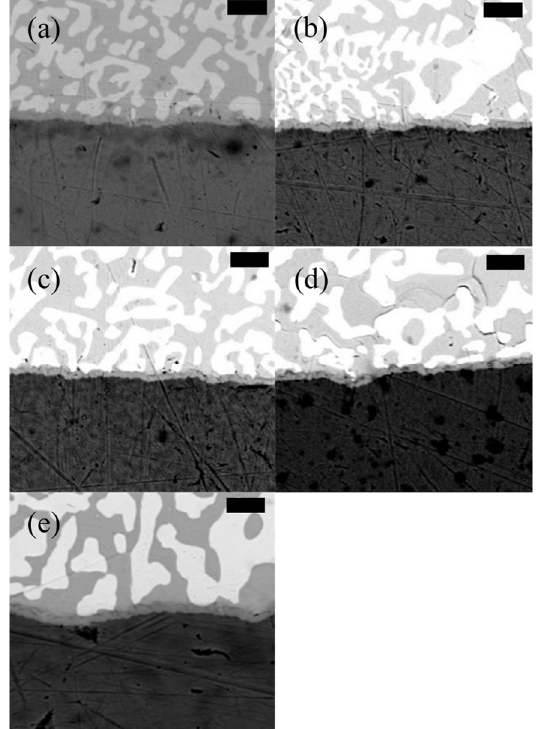
Figure 9. SEM images of 42Sn58Bi reflowed with ( a ) a peak temperature of 165 °C and 45 s TAL, ( b ) peak temperature of 165 °C and 90 s TAL, ( c ) peak temperature of 177 °C and 45 s TAL, ( d ) peak temperature of 177 °C and 90 s TAL and ( e ) peak temperature of 190 °C and 90 s TAL. The scale bar is 4 µm in all images.